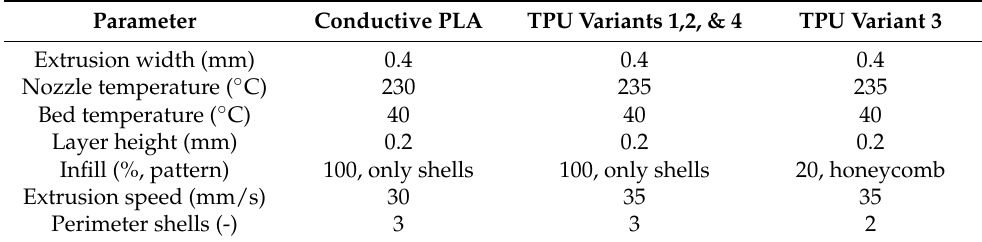
Table 2. Process settings for sample